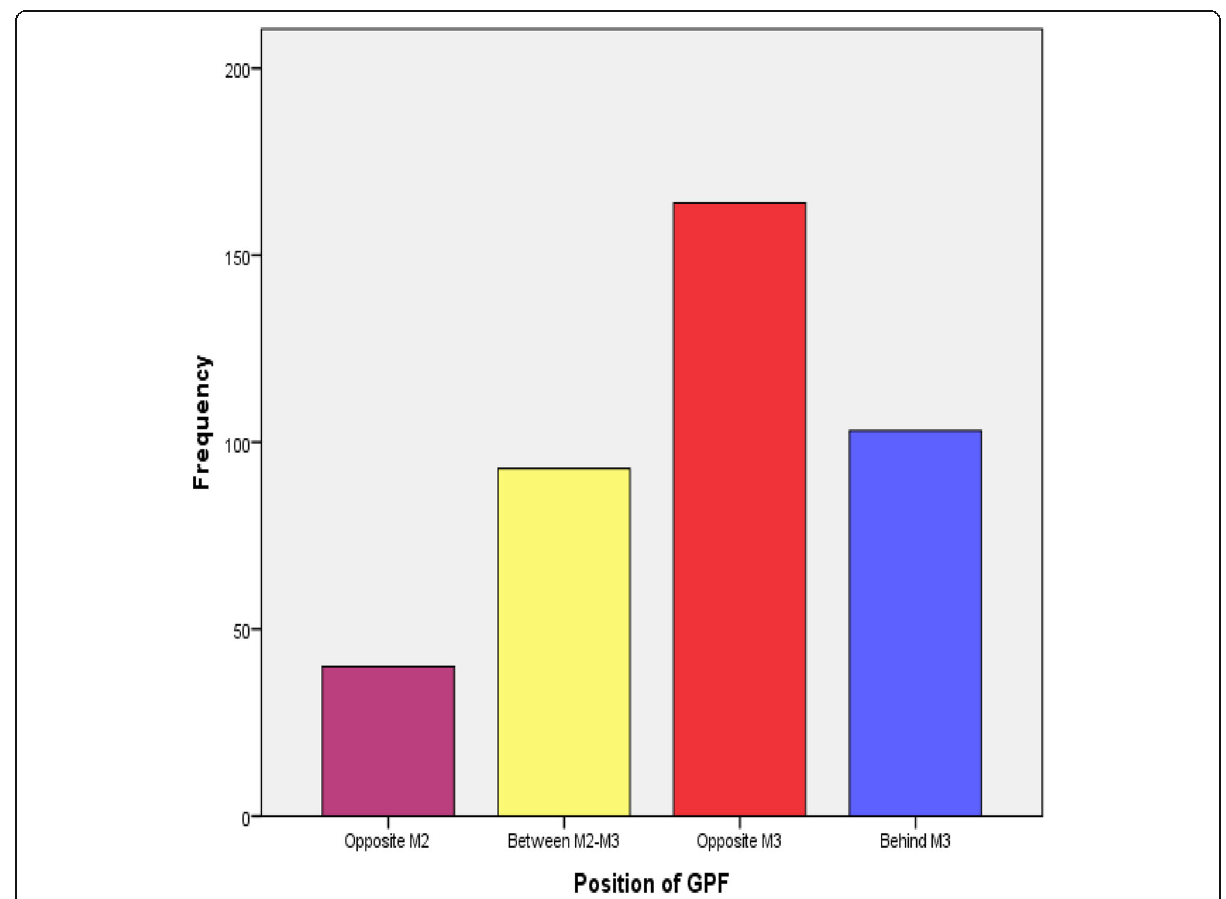
Fig. 4 Bar chart of the frequency of position of the greater palatine (GPF) in CT scans